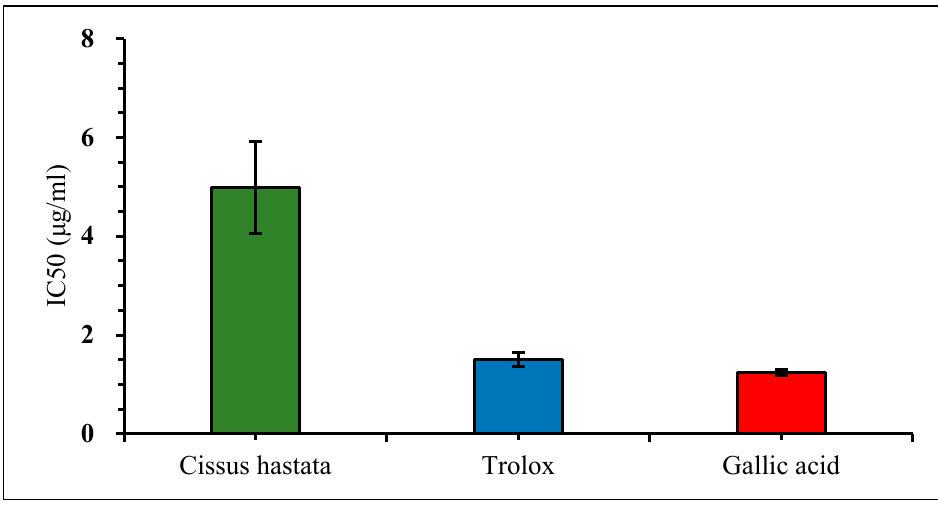
Figure 3. Comparison of the IC50 value (DPPH radical scavenging activity) among C. hastata methanolic leaf extract, trolox, and gallic